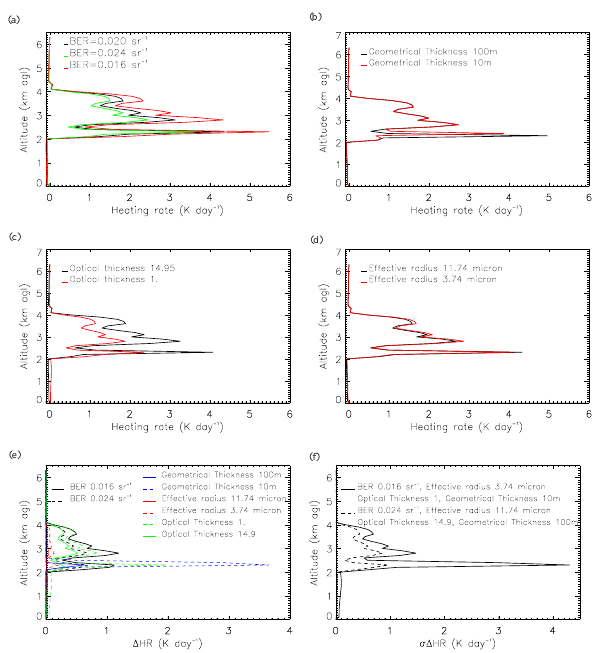
Fig.10. SensitivityoftheLEANDRE-derivedheatingrateprofileat5 ◦ Non14Juneto: (a) dustBER, (b) cloudgeometricaldepth, (c) cloudopticalthicknessand (d) effectiveradiusofcloudparticles.Uncertainties(in Kday − 1 )foreachofthepreviousvariablesareshownin Fig. 10. Sensitivity of the LEANDRE-derived heating rate profile (e) . UncertaintiesarecomputedwithrespecttoreferenceprofileshowninFig.7candusingtheRaCHmodel. Thetotaluncertaintyonthe HR,takenasthesumofthequadraticerrorsofallvariablepreviouslyshownareshownin (f) :thedashedlinecorrespondstotheminimum totaluncertaintyandthesolidlinecorrespondstothemaximumtotaluncertainty(seetextfordetails). at 5 ◦ N on 14 June to: (a) dust BER, (b) cloud geometrical depth, (c) cloud optical thickness and (d) effective radius of cloud parti- cles. Uncertainties (in Kday − 1 ) for each of the previous variables are shown in (e) . Uncertainties are computed with respect to ref- erence profile shown in Fig. 7c and using the RaCH model. The total uncertainty on the HR, taken as the sum of the quadratic er- rors of all variable previously shown are shown in (f) : the dashed line corresponds to the minimum total uncertainty and the solid line corresponds to the maximum total uncertainty (see text for